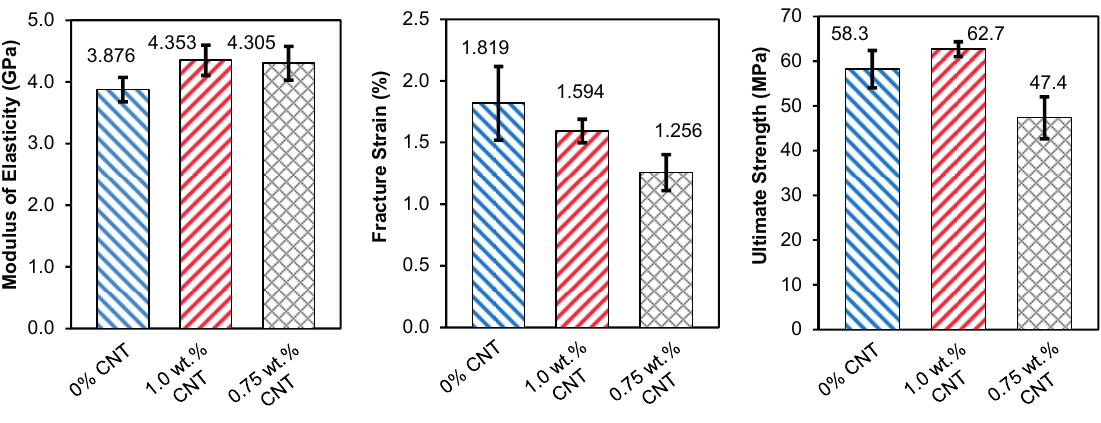
Figure 7. Mechanical properties of the aramid/epoxy composite (=0% CNT) and the CNT